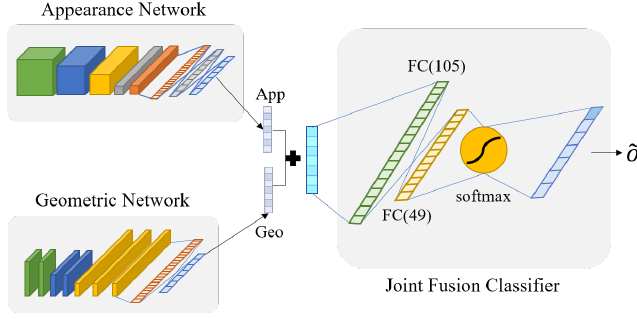
Figure 12. The structure of joint fusion